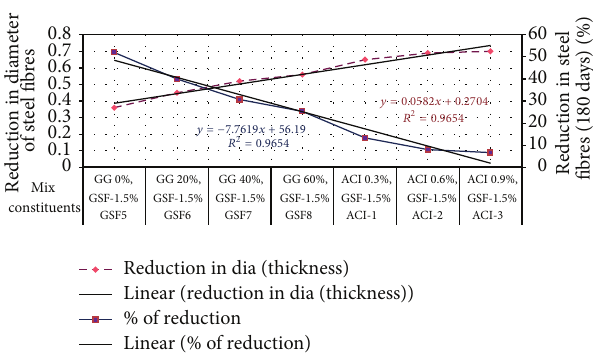
Figure 15: Variation of reduction in steel fibre diameter and the percentage reduction in steel fibre diameter for various concrete